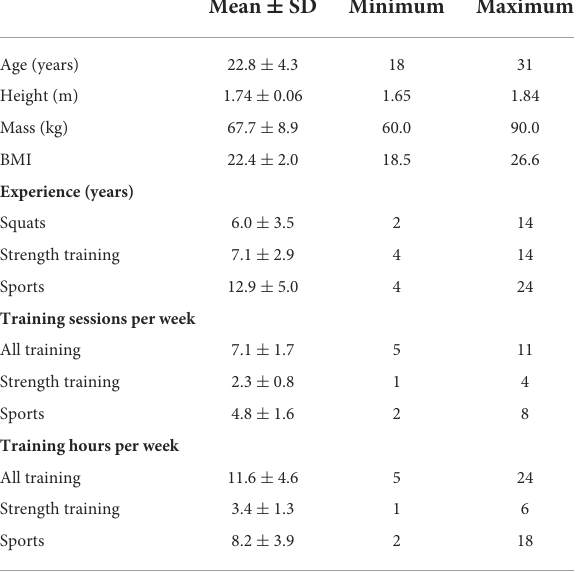
TABLE 1 Participant characteristics ( n = 16; female/male =